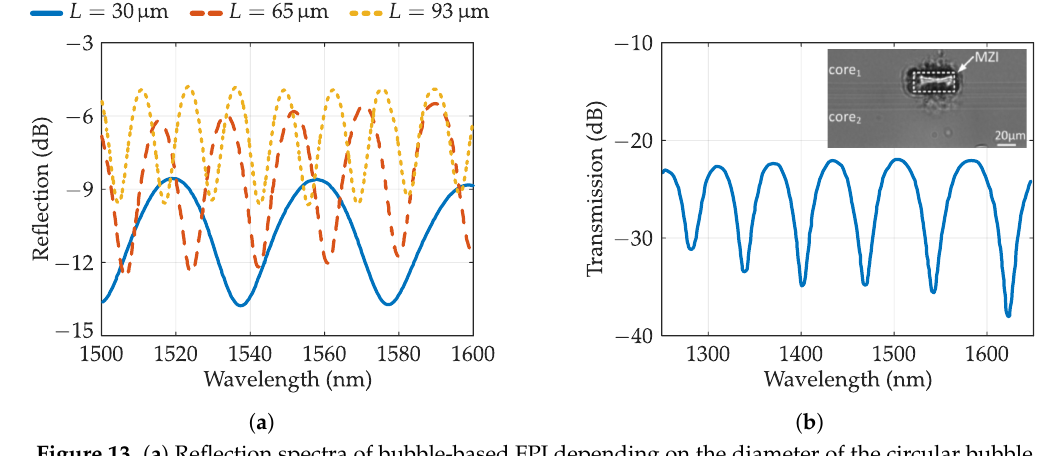
Figure 13. ( a ) Reflection spectra of bubble-based FPI depending on the diameter of the circular bubble, reproduced from [134]. ( b ) Transmission spectrum of an MZI manufactured by means of a through-hole in one core of a twin core fiber, reproduced from [139]. Inset: microscope top-view image of the MZI (adapted with permission from [139], ©The Optical